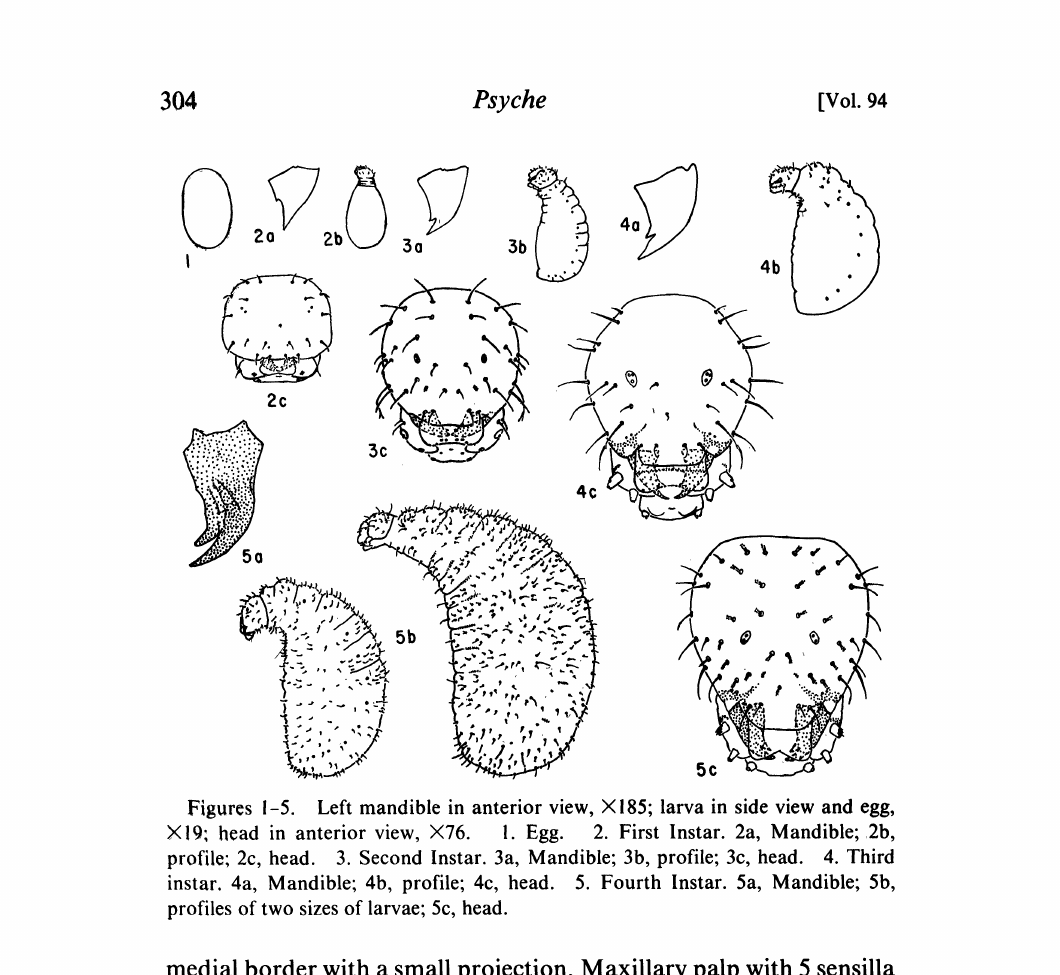
Figures I-5. Left mandible in anterior view, XI85; larva in side view and egg, X g; head in anterior view, 76.